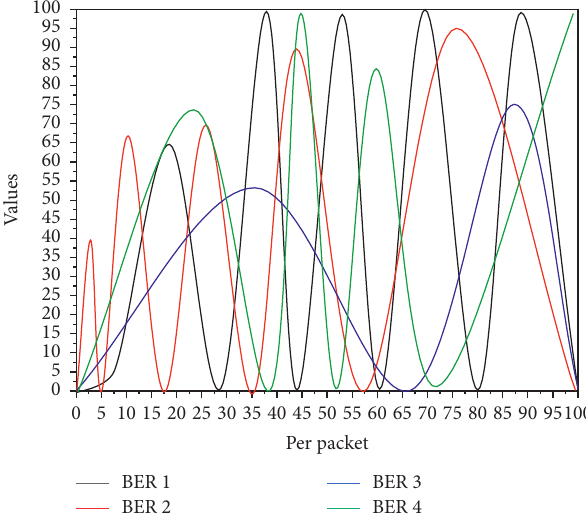
Figure 8: Simulation results of the high-speed hydroacoustic OFDM communication system based on Turbo codes, BER per packet.